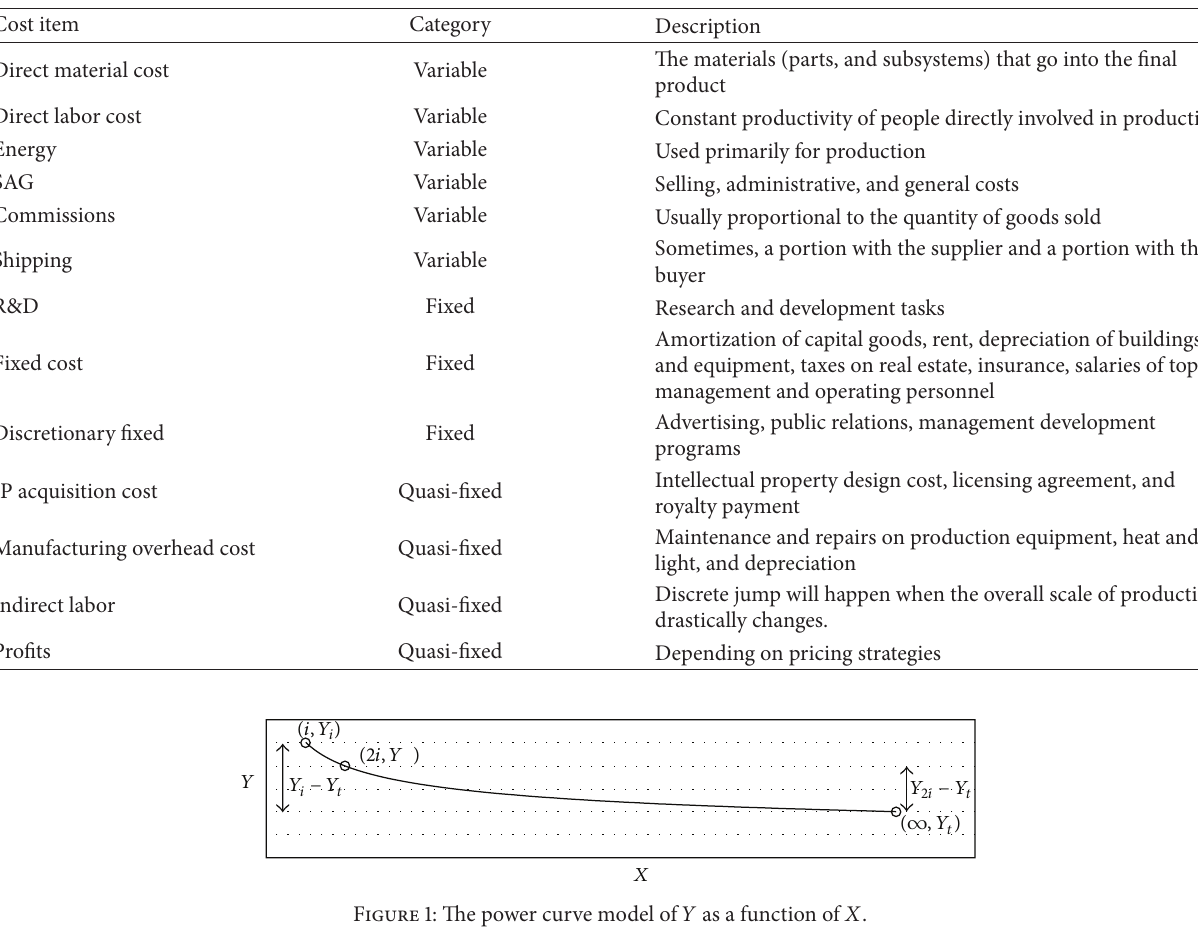
Table 1: Cost classification.